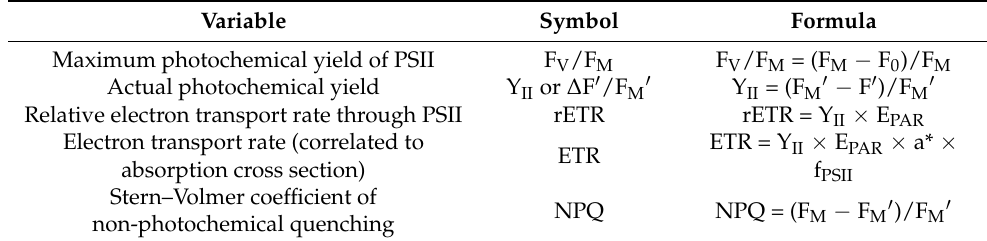
Table 3. Basic variables calculated from saturating pulse analysis of Chl fluorescence quenching when measuring [3,147,166,182]: F 0 , F V , F M —minimum, variable and maximum fluorescence yield in the dark-adapted state; F (cid:48) , F V (cid:48) , F M (cid:48) —steady-state, variable and maximum fluorescence in the light- adapted state; E PAR —photosynthetically active irradiance intensity; a* is the Chl-specific absorption cross-sections and f PSII is the fraction of absorbed quanta by PSII [196].